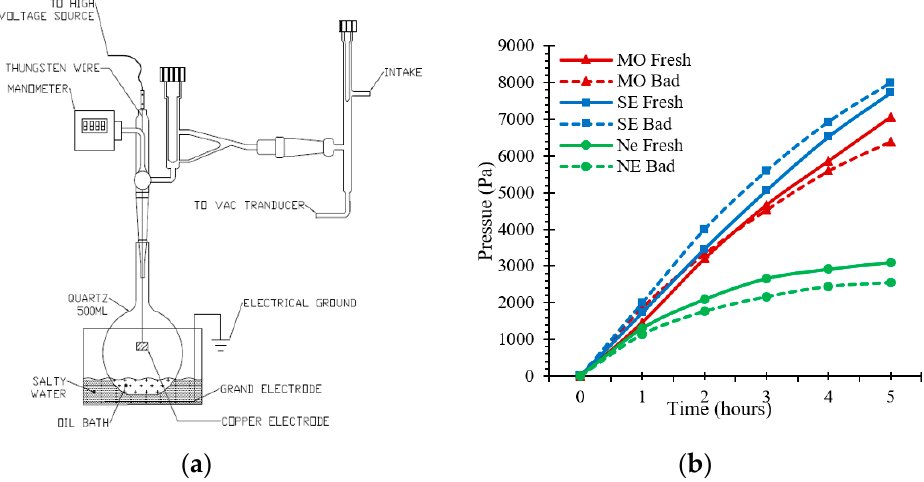
Figure 2. Experimental of the low energy discharge activity in various dielectric fluids; ( a ) test set up used for low energy discharging; ( b ) gassing tendencies for fresh and aged fluids under electrical discharges.